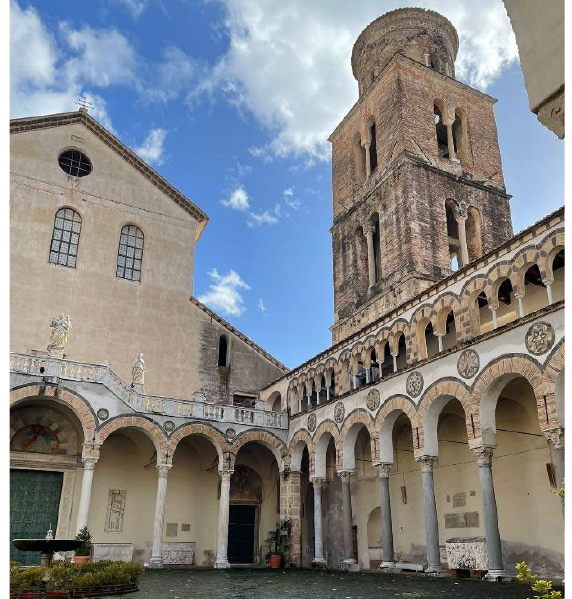
Figure 4. The Quadriportico of the Cathedral of San Matteo. In the picture: on the east side the bronze door and on the south side the bell